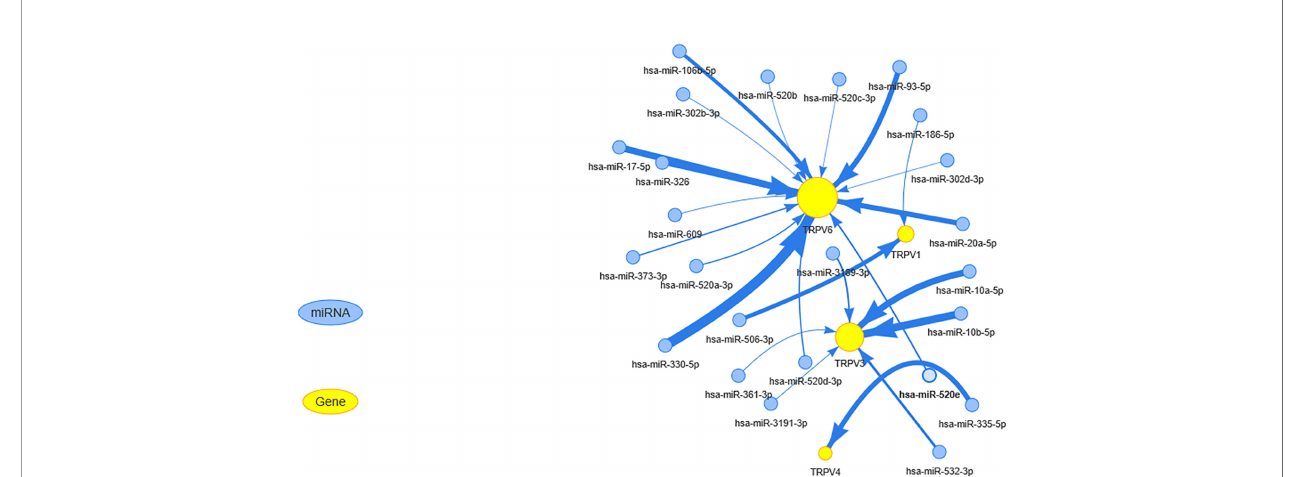
FIGURE 5 | The miRNA regulation network of TRPV channel-related genes. The connection between mRNA and miRNA indicates that the mRNA is regulated by this miRNA. The larger the yellow dot size, the greater the association with miRNA regulation. The size of arrow edge width depends on the absolute value of the correlation coef fi cient.